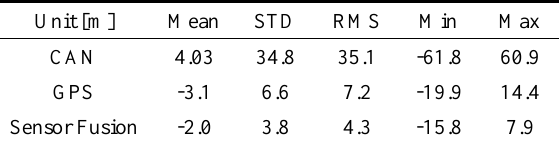
Table 2. Errors of position